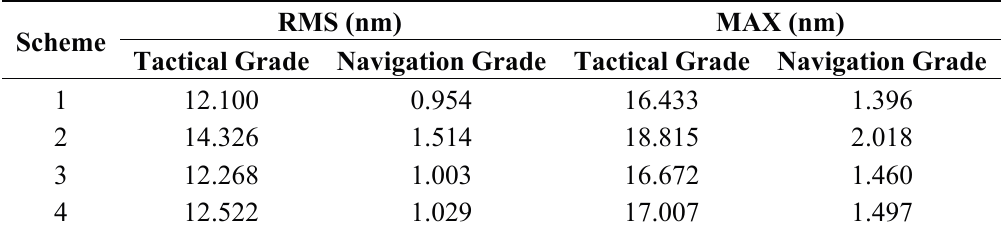
Table 5. The navigation position error for different